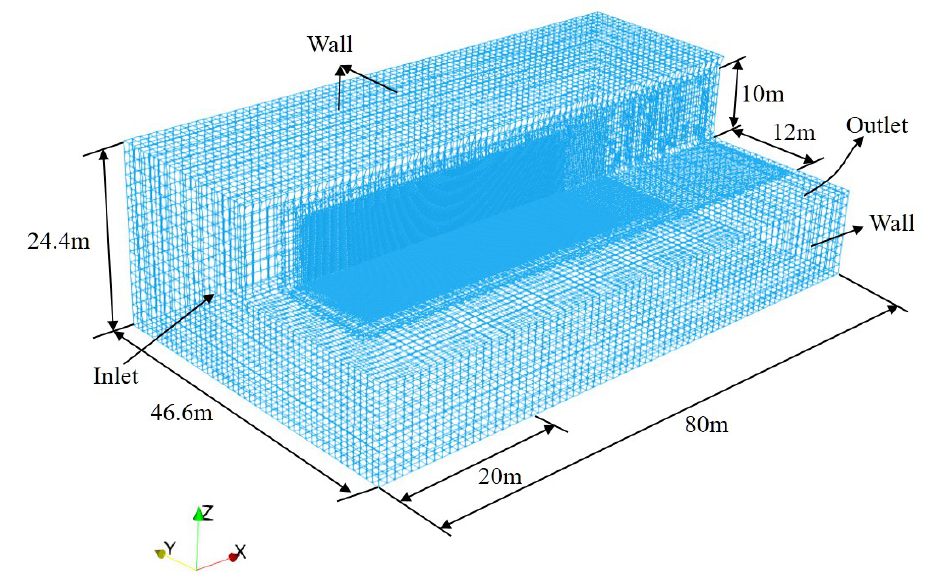
Figure 1. Illustration of the computational domain.